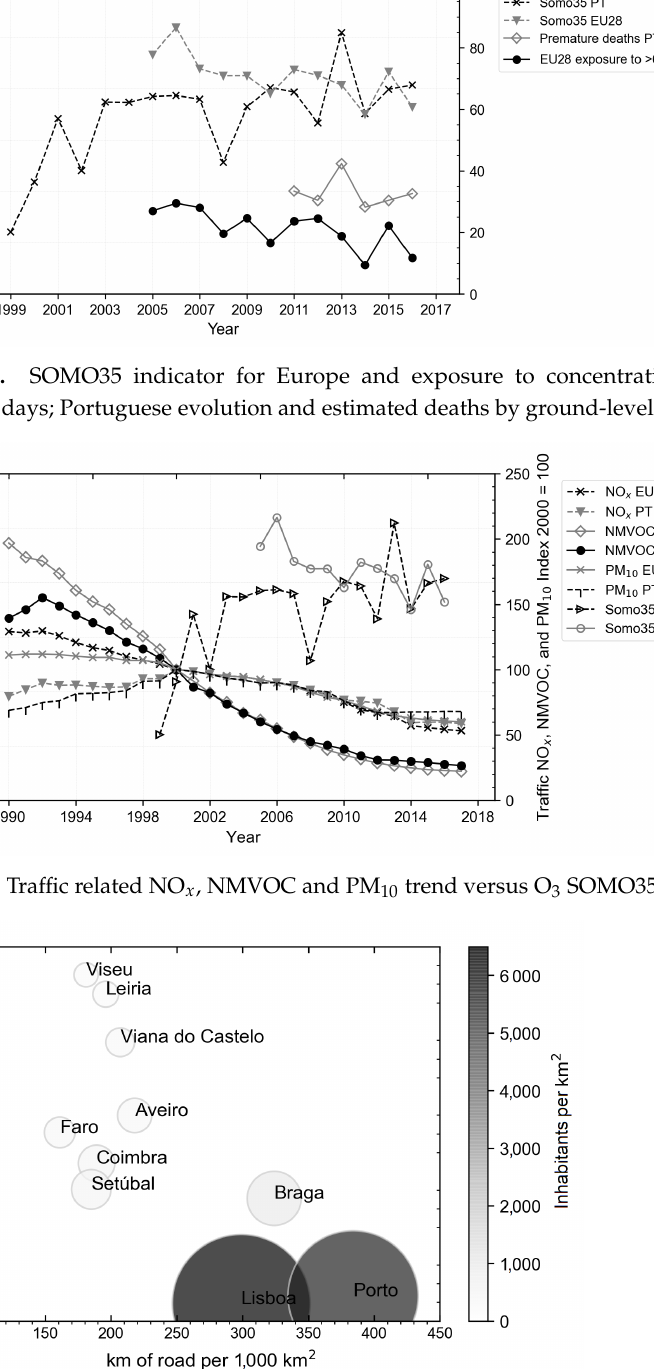
Figure 5. Top 10 Portuguese cities by km of road, km 2 and population